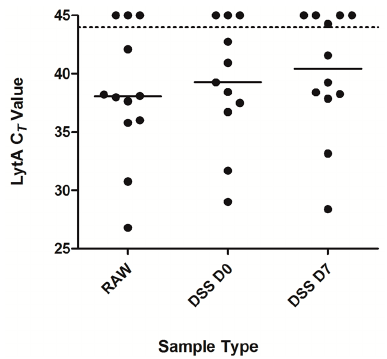
Figure 4. Detection of pneumococci in DSS of clinical samples. Saliva was collected from 12 school children (ages 4–10 years) and either frozen or processed for DSS immediately. DNA isolation was performed from raw saliva and DSS specimens from the same donors simultaneously. Samples are represented by dots with the median C T value depicted per condition. Pneumococcal-specific PCR identified 8 out of 12 children positive in both raw saliva and DSS at day zero. At 7 days at RT, 7 out of 12 children were positive for the pneumococcus-specific signal, indicating a loss of 1 positive result from sample weakly positive already at day zero.